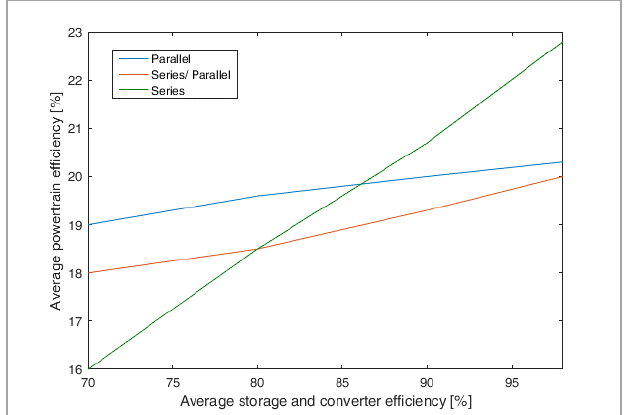
Figure 10. Average power train efficiency over the simulated road missions as a function of storage and converter efficiency (%) [22].